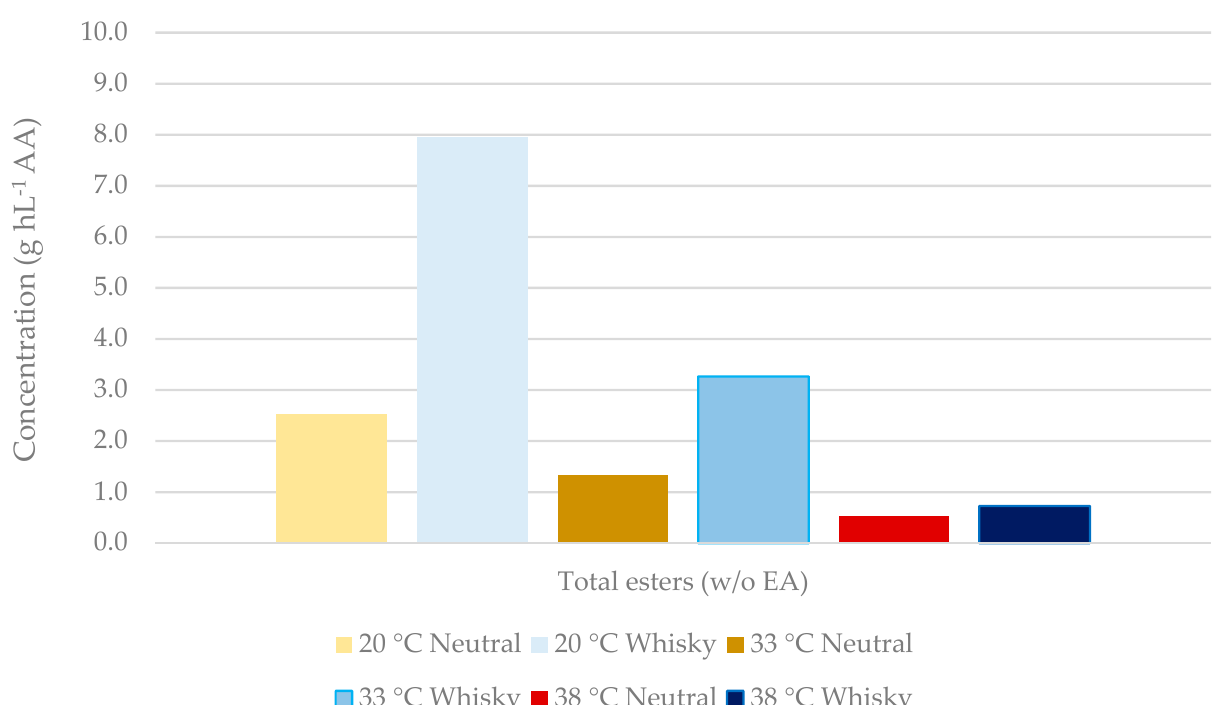
Figure 3. Effect of yeast strain and temperature on ester formation during corn-whisky fermentation. Congener concentrations were measured in distillates from single distillation with a 30 L capacity hybrid still and are expressed in grams per hectolitre of absolute alcohol (AA, 100% vol. alcohol). EA: ethyl acetate. Esters analysed: isoamyl acetate, ethyl caprylate, ethyl caprate. Analysis courtesy of Lallemand Biofuels & Distilled Spirits R&D, Montreal, QC, Canada.